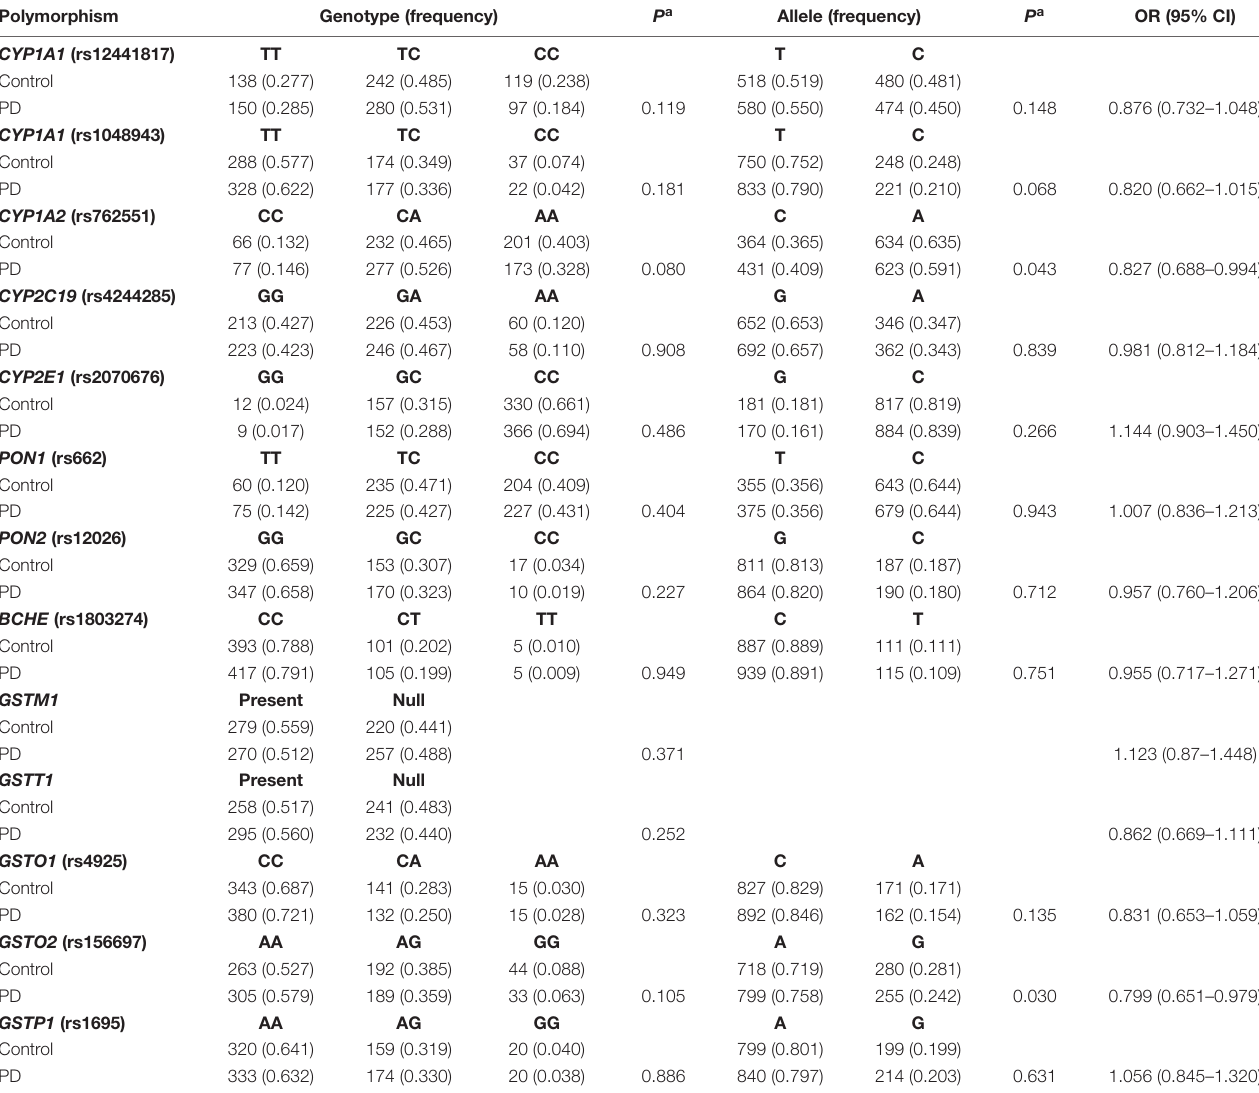
TABLE 1 | Genotype and allele frequencies of polymorphisms of CYPs, esterases and GSTs in PD patients and controls.